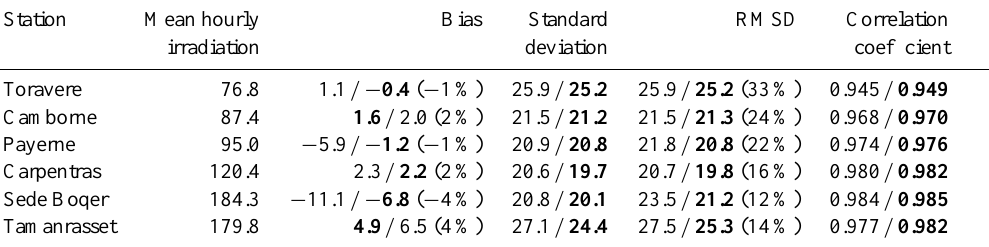
Table 4. Comparison of differences for hourly irradiation, in Jcm − 2 . The mean value is obtained from the measurements. The first value is I HC3v3 and the second is I HC3McClear , with the best value in bold. Bias and RMSD of I HC3McClear relative to the mean irradiation are given in